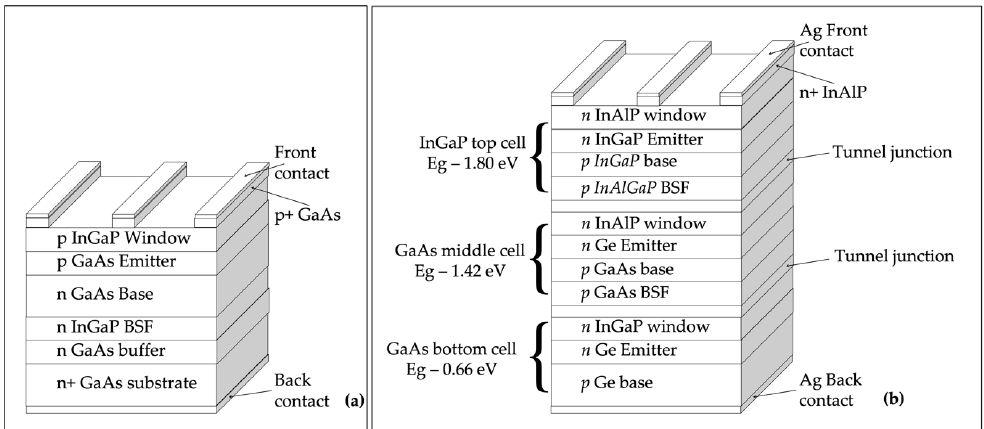
Figure 2. ( a ) GaAs single junction (SJ) with an InGaP Back Surface Field (BSF) layer. ( b ) GaAs-based triple junction (3-J) suitable for harvesting sunlight in a wide range from 0.69 to 1.87